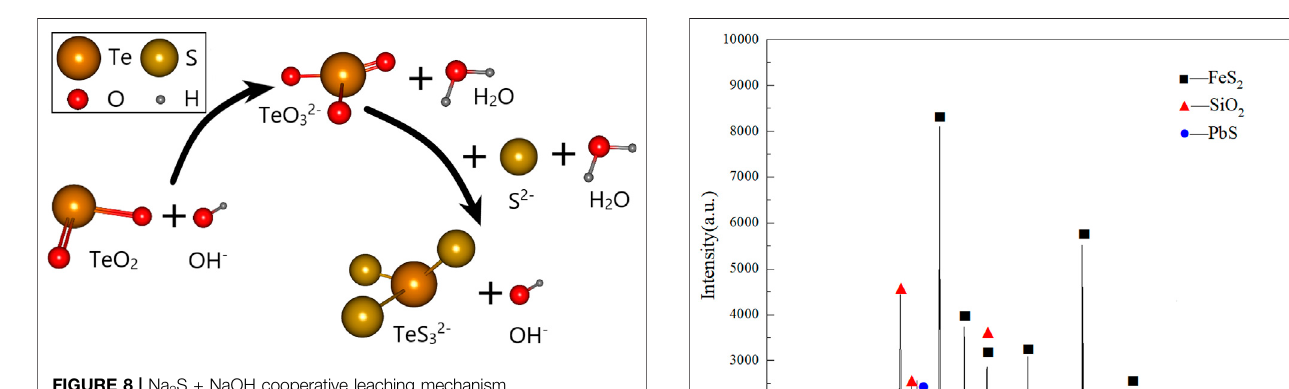
FIGURE 8 | Na 2 S + NaOH cooperative leaching